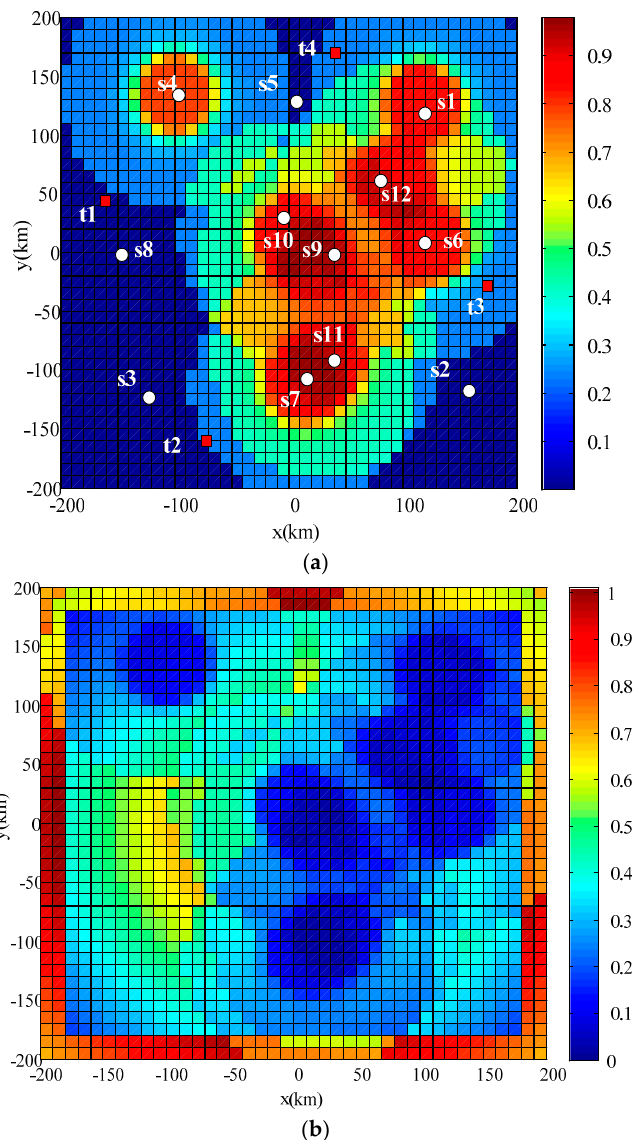
Figure 9. Sensor deployment after scheduling. ( a ) Target detecting probability distribution; ( b ) target detecting risk distribution.